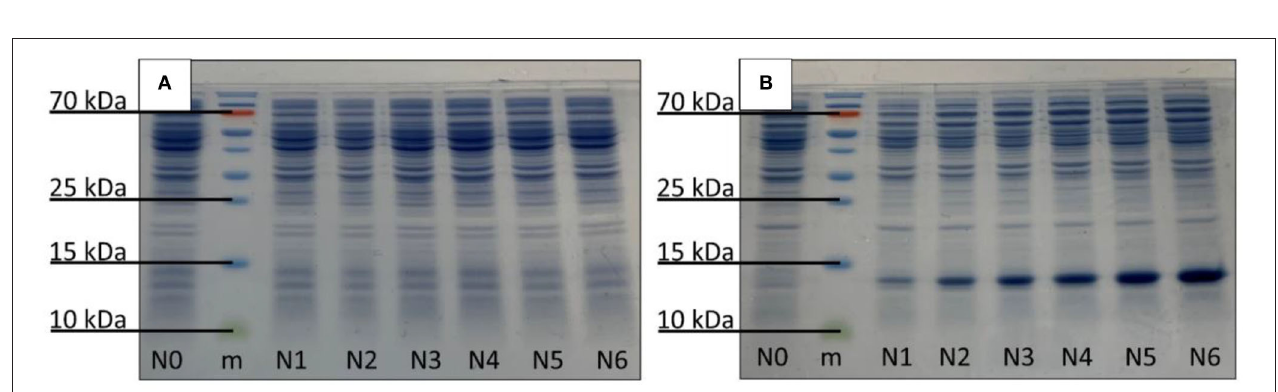
FIGURE 2 | Chemometric analysis of the FT-IR spectral data: (A) PCA scores plot of all samples, (B) PC–DFA scores plots of all samples, (C) control samples, and (D) induced samples. Red arrows show the trend detected for the induced bacterial strains from N0 to N6, while the blue arrows indicate the effect of incubation time on a control set which shows no pattern linked to the protein production or the different examined strains.